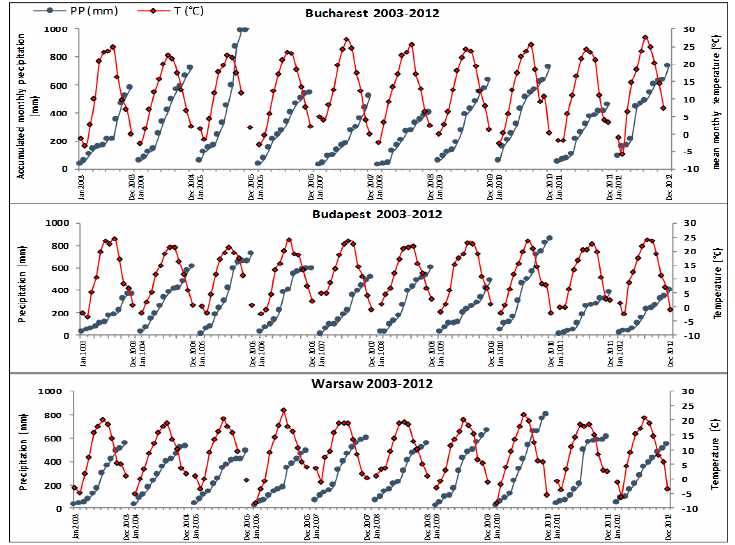
Figure 11. Weather conditions in Bucharest, Budapest, and Warsaw. Red color indicates monthly mean air temperature (°C) and blue color indicates accumulated monthly precipitation (mm). Dots represent months.